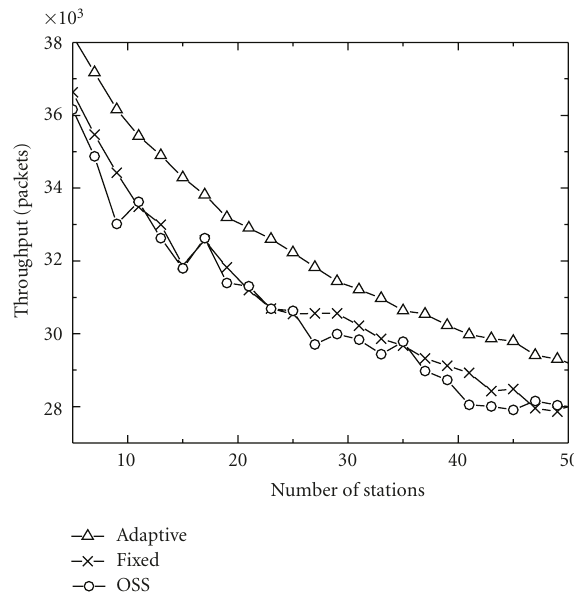
Figure 9: Throughput as a function of number of stations.